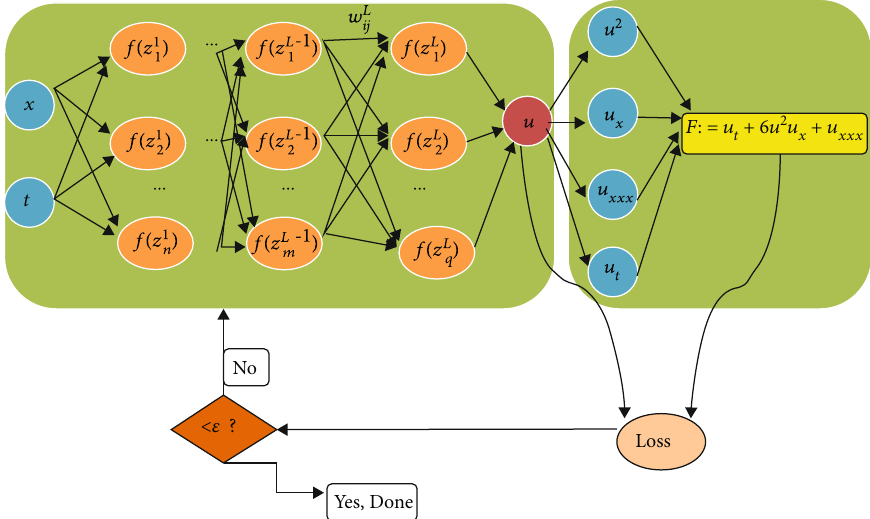
Figure 6: Schematic of physics-informed neural network for the mkdv equation.